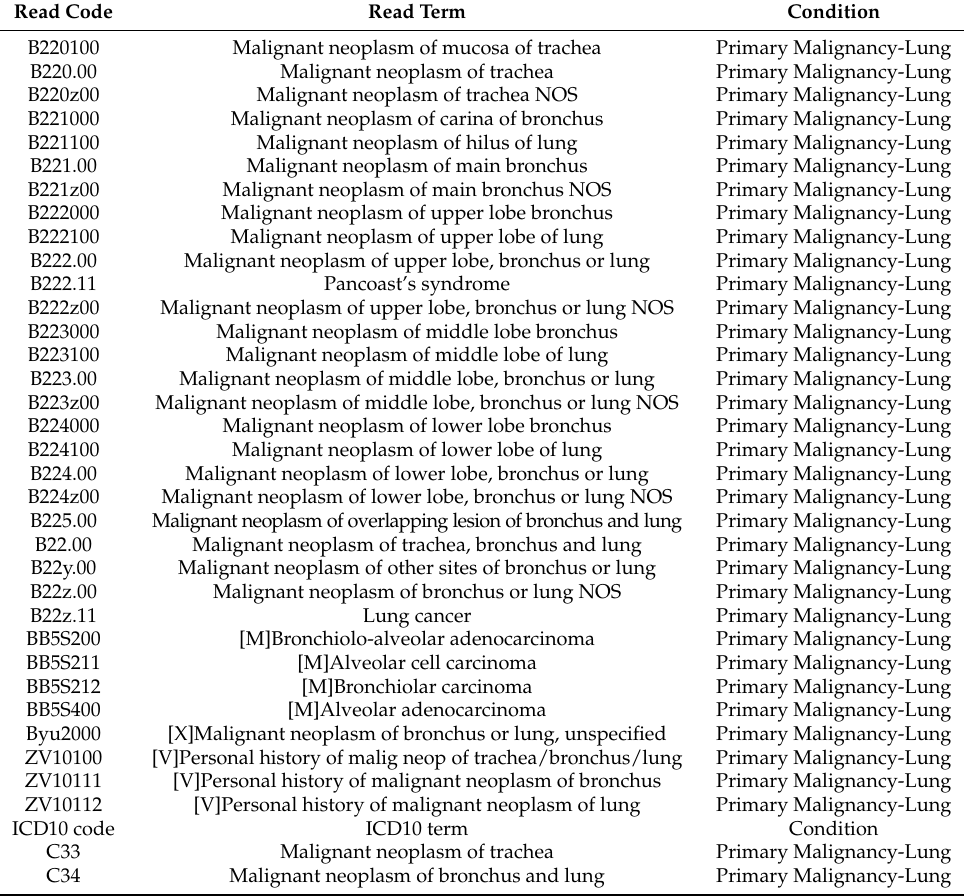
Table A1. Read codes and their associated read terms and